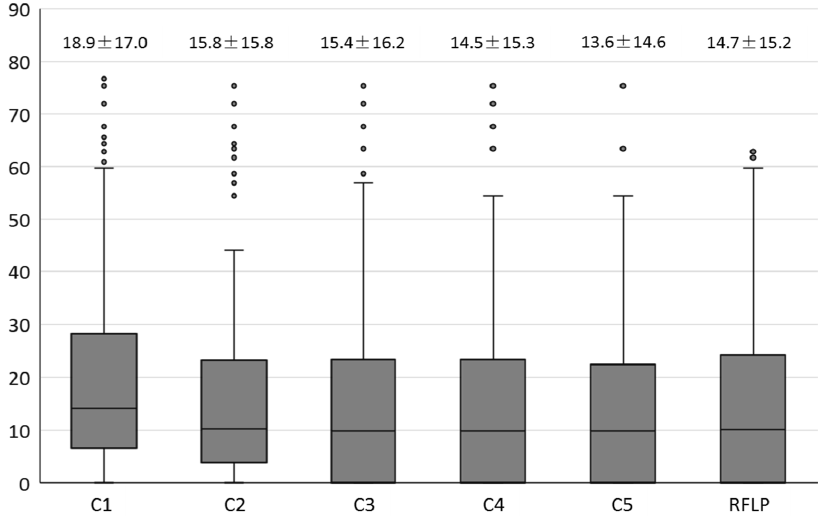
Figure 1. Paired geographic distance in different genotyping strategies. Figure legend: In this figure, the distance between parents’ residence among pairs of clustered strains in different genotyping strategies was presented on the box plot, marked with the mean value and standard deviation. C1 refers to 24-locus MIRU VNTR alone; C2 refers to the combination of 24-locus MIRU VNTR plus locus 3820; C3 refers to the combination of 24-locus MIRU VNTR plus loci 3820 and 3232; C4 refers to the combination of 24-locus MIRU VNTR plus loci 3820, 3232, and 2163a; C5 refers to the combination of 24-locus MIRU VNTR plus loci 3820, 3232, 2163a, and 4120; RFLP refers to IS6110-RFLP; Multiplicity test (LSD) of ANOVA showed that the paired geographic distance of C2 to C5 was significantly shorter than that of C1 ( p = 0.001~0.011), which was also comparable to the RFLP